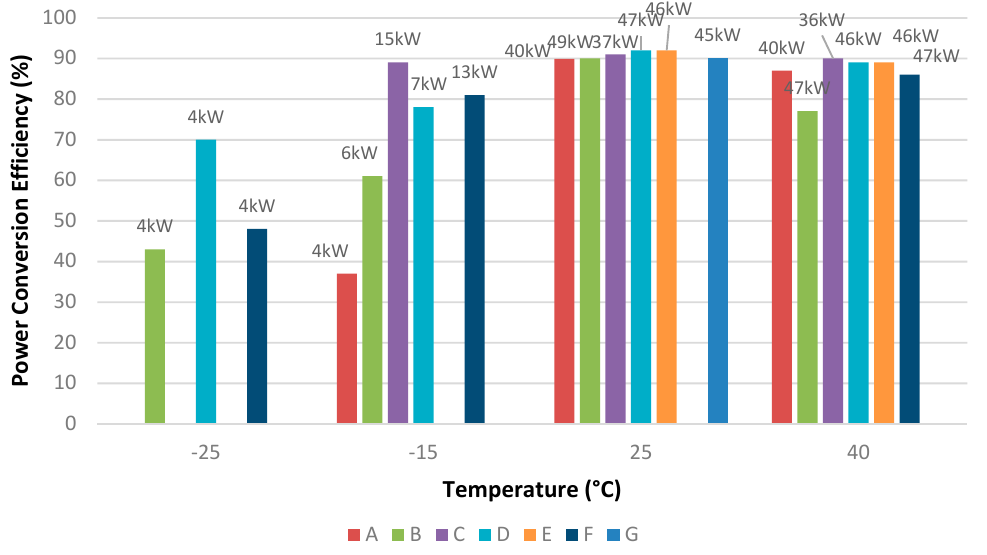
Figure 3. Power conversion efficiency results as a function of the temperature.